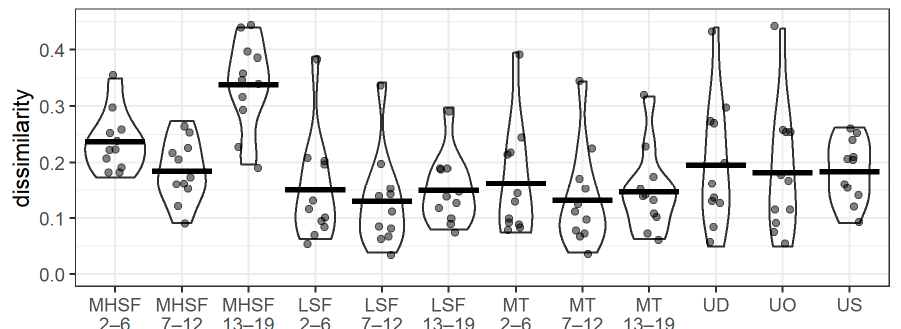
Figure 5. Dissimilarity across all pairwise combinations of disturbance/time categories and undis- turbed habitat types (total pairwise comparisons, n = 11). Horizontal bars show group means. MHSF = moderate-high-severity fire; LSF = low-severity fire; MT = mechanical treatment; UO = undisturbed open forest; US = undisturbed shrub; UD = undisturbed dense forest. Numbers indicate ranges of years since disturbance.